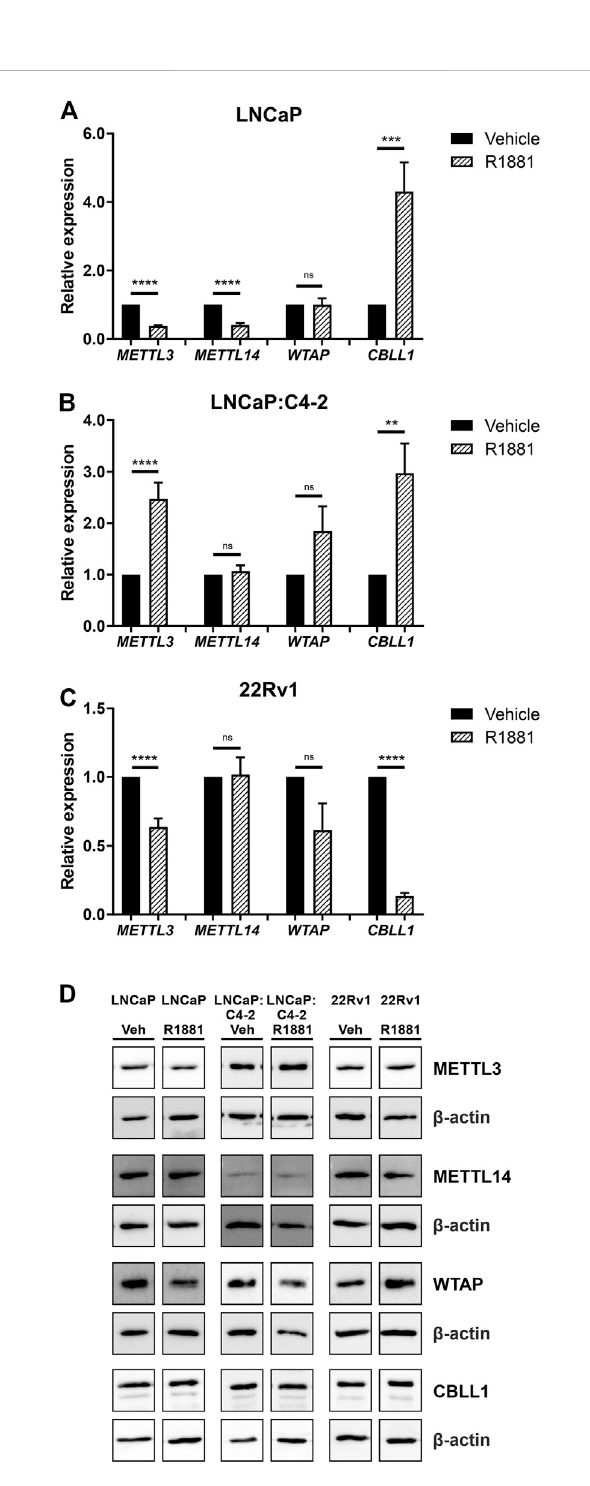
FIGURE 5 METTL3 , METTL14 , WTAP and CBLL1 expression in PCa cell lines LNCaP ( n = 9) (A) , LNCaP:C4-2 ( n = 9) (B) , 22Rv1 ( n = 6) (C) with vehicle or R1881 (1 nM) treatment for 72 h; mRNA expression analysed by qRT- PCR relative to β -actin and protein expression analysed using western blot (D) . ns, not signi fi cant; ** p ≤ .005, *** p ≤ .001, **** p ≤ .0001 by unpaired t